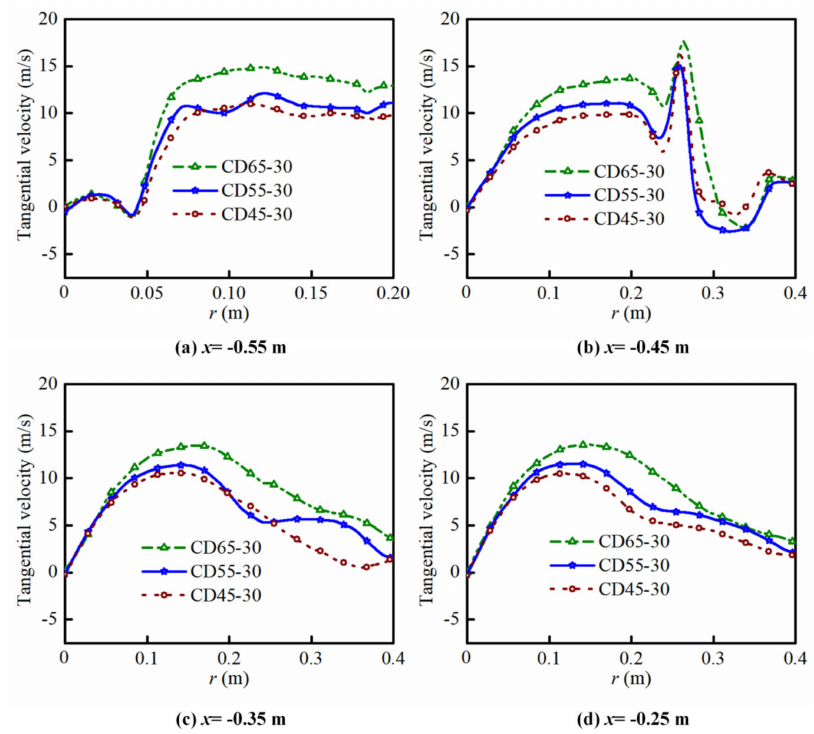
Figure 13. Tangential velocity of CD65-30, CD55-30, and CD45-30 at different axial positions. Referring to the temperature contour of 1800 K, the location of the temperature contour at 1800 K is taken as the location of the flame front. It is found from Figure 14 that the length of the flame front gradually shortens as the angle decreases. The presence of high temperature in the hood is beneficial to the ignition. Considering the effect of combustion expansion on the flame, CD55-30 and CD45-30 are easily blown out. From the perspective of flame stability, the blade’s angle of the two does not match the first-stage blades. The locally uneven high temperature of CD55-30 and CD45-30 promotes the formation of NO x when the air excess coefficient is greater than 1.